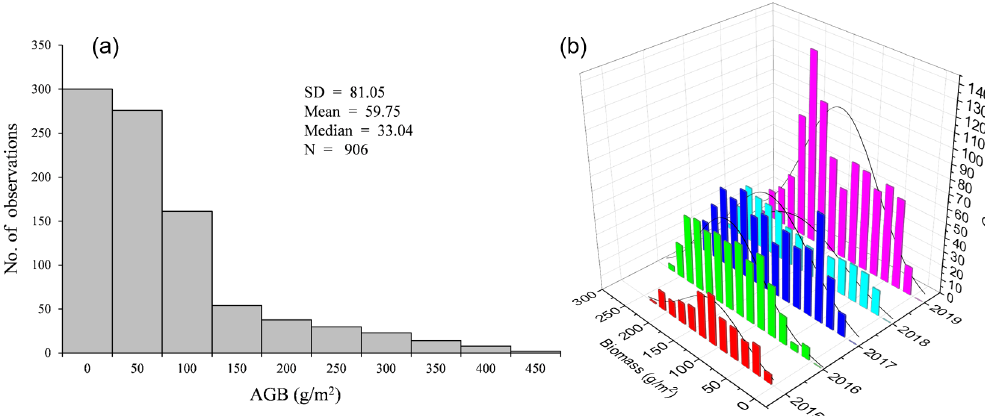
Figure 5. Histograms of field-measured AGB values at quadrat scale (a) and UAV-estimated AGB values of different years at the photo scale (b)